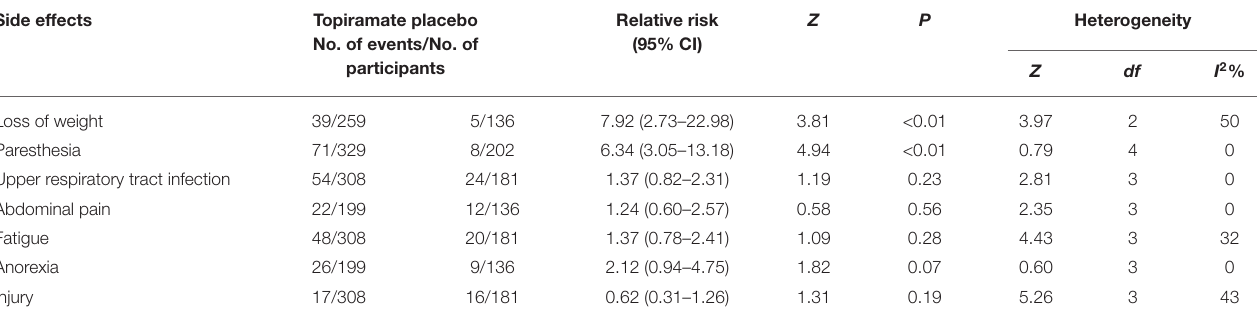
TABLE 2 | Side effects and adverse reactions of topiramate vs.